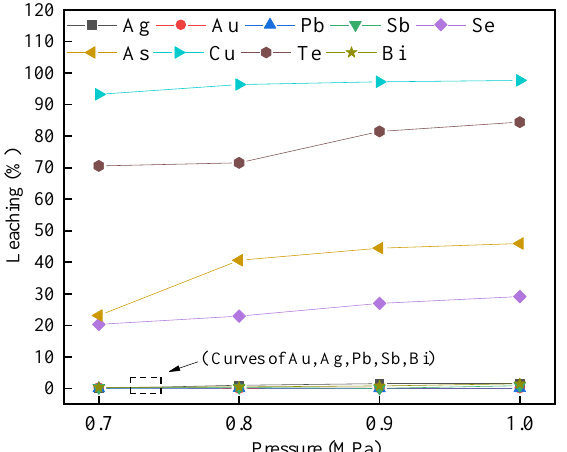
Figure 7. Effect of the leaching pressure on the leaching of each element (t = 2 h, T = 150 °C and H 2 SO 4 = 250 g/L).